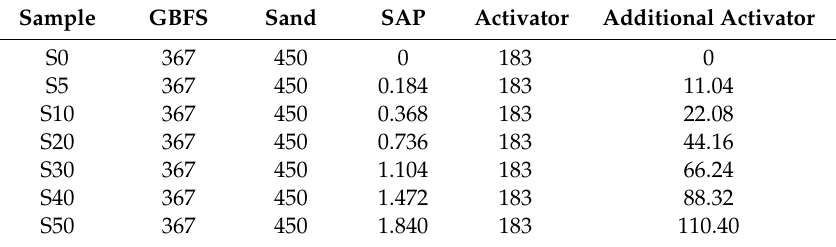
Table 2. The mix proportion of AAS mortars (g /